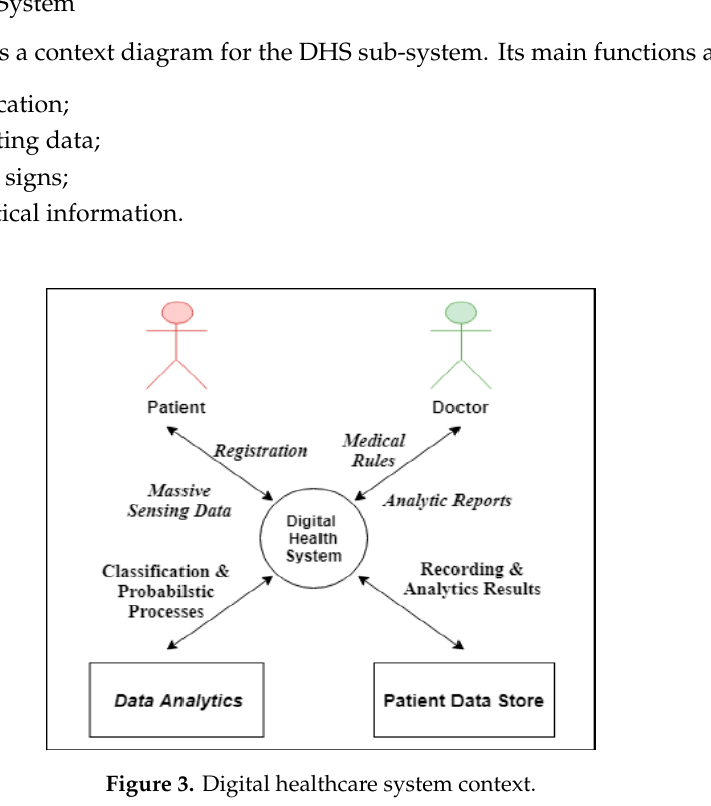
Figure 2. Smart surveillance system context .